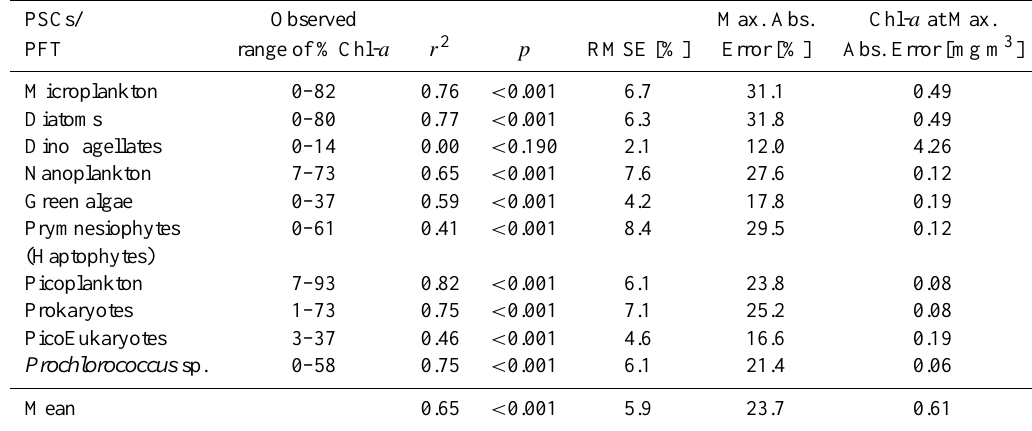
The relationships between Chl- a and % Chl- a shown in Fig. 2 can be quantified using a least square fit (thick solid lines in Fig. 2), enabling the estimation of % Chl- a of each PFT from Chl- a alone, hence from satellite-derived Chl- a fields (O’Reilly et al., 1998; McClain et al., 2009). Table